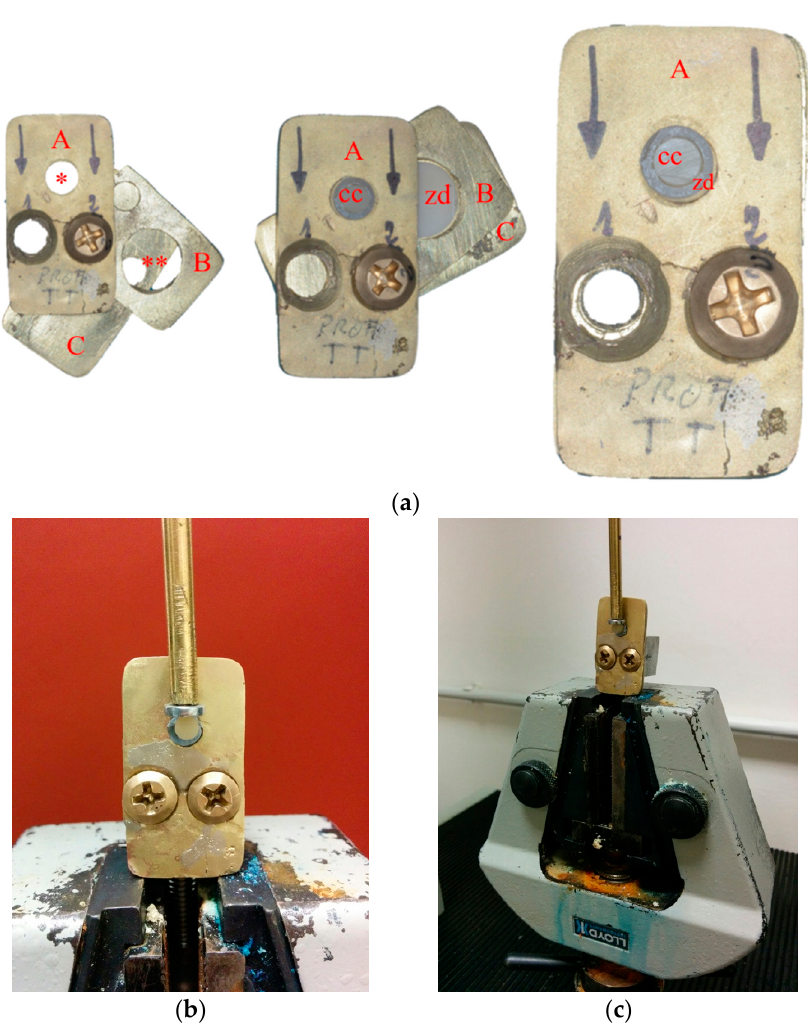
Figure 2. ( a ) The custom-made device in brass used to place the specimens onto the testing machine. It was composed by three assembled plates (A–C) held together by means of two screws (1–2). Plate A was equipped with a hole (*) to fix the composite cylinder (cc). Plate B was equipped with a larger hole (**) to fix the zirconia disk (zd). Black arrows indicate load direction during the testing phase; ( b , c ) Broader view of a specimen during the test.